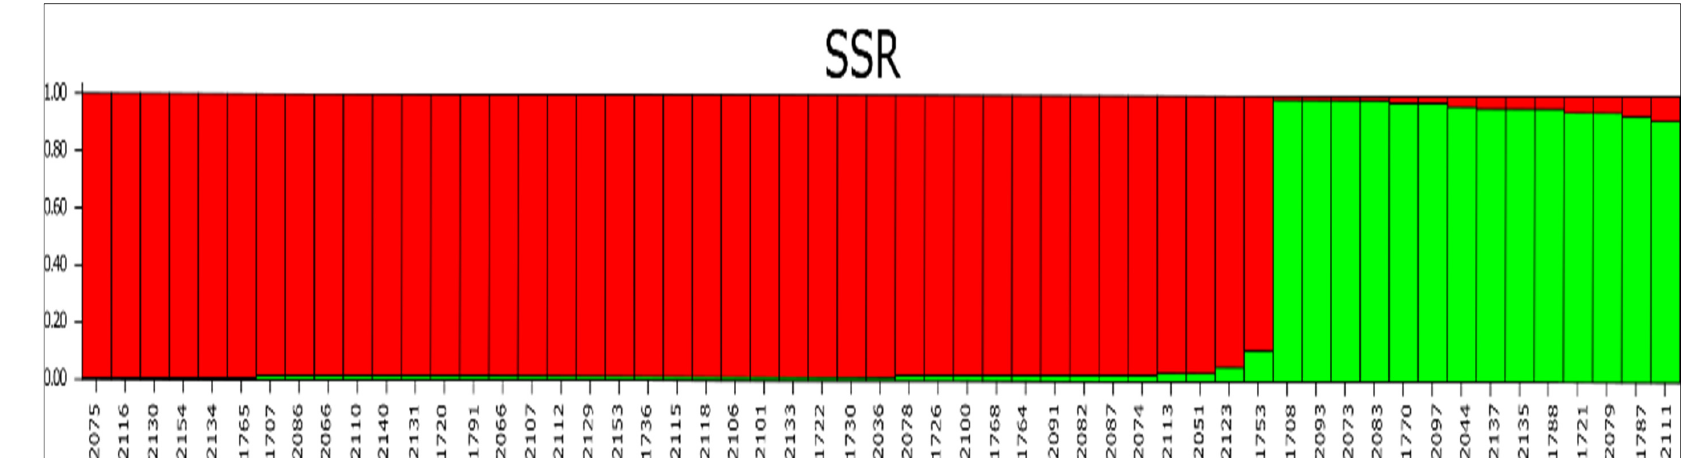
Figure 3. Genetic structure estimate for C. chinense accessions by Simple Sequence Repeat (SSR) primers. Group I is indicated by the color red and group II is indicated by the color